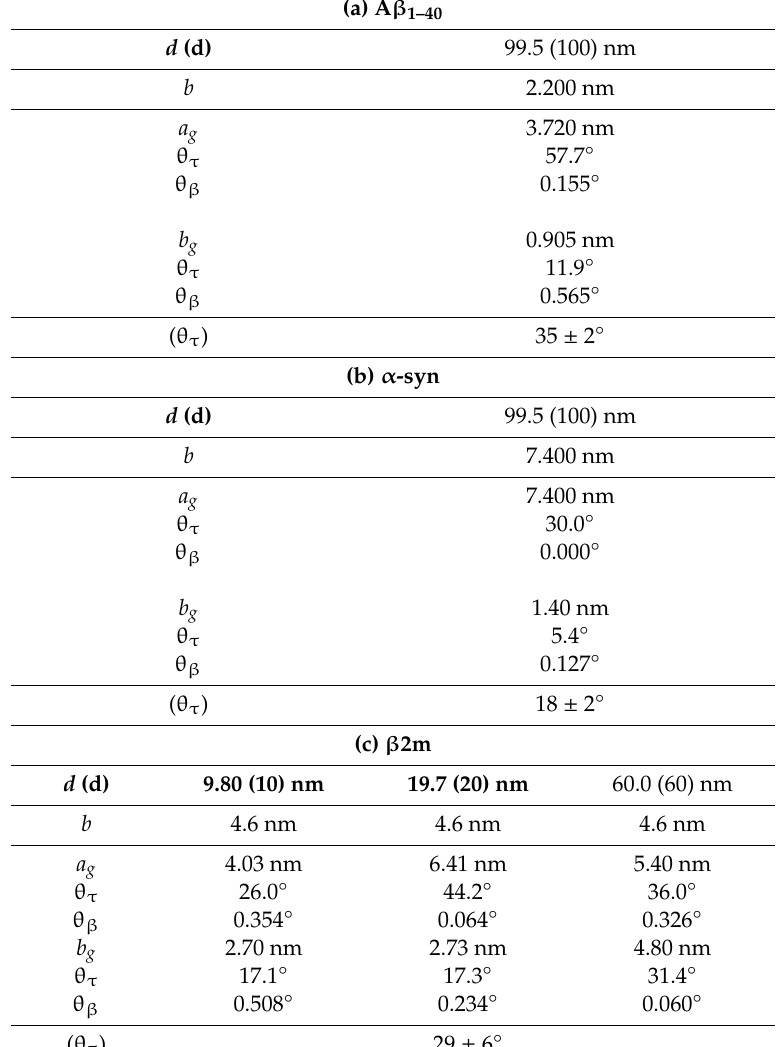
Table 3. The list of extracted tilting angles ( θ τ and θ β ) for the lower coverage for ( a ) A β 1–40 , ( b ) α -syn, and ( c ) β 2m. The average tilting angle for each peptide is shown at the bottom for each peptide in ( θ τ